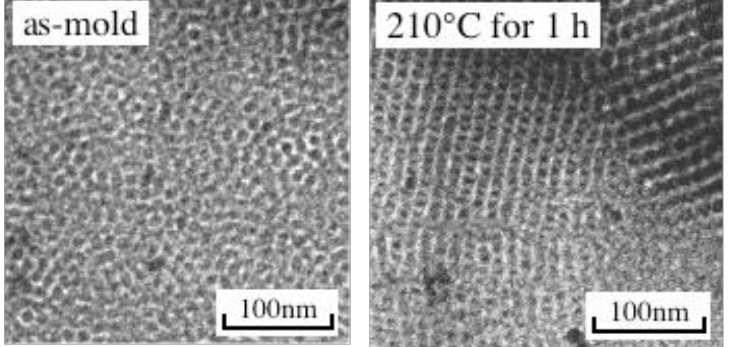
Figure 2. Transmission electron microscopic photographs for the as-mold sample and the sample further annealed at 210 °C for 1 h. The PCHD phase is selectively stained with RuO and appears 4